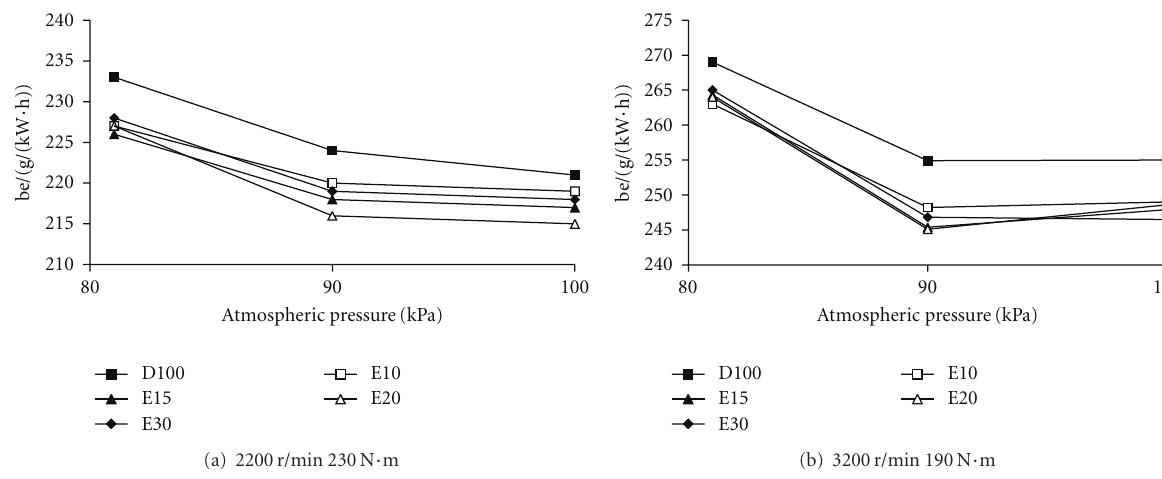
Figure 1: E ff ects of di ff erent atmospheric pressure and mix proportion on equivalent BSFC.